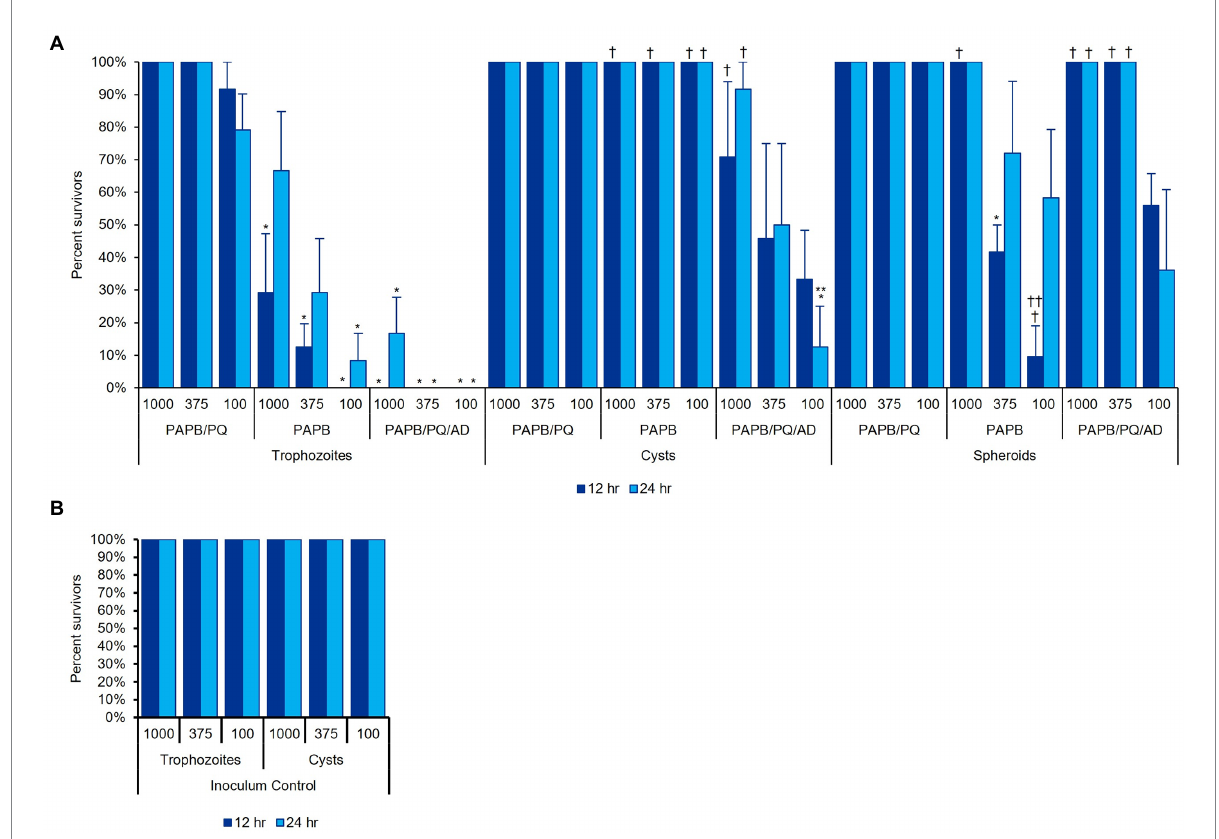
FIGURE 11 Acanthamoeba polyphaga (ATCC 30461) in three different cell concentrations (1,000, 375, or 100 cells per 100 μ l) was used to examine MPS disinfection efficacy against (A) trophozoites, cysts, and spheroids, after cells had adhered to the plate for 12 or 24 h. (B) An inoculum control was run concurrently with the same cultures used in (A) . Each bar represents a mean ± SE of 3 replicates, each replicate being composed of 8 wells from which percent survivorship was calculated. Statistical analysis via 2-way ANOVA: comparisons versus a MPS within the same cell condition and same time, * p < 0.05 vs. PAPB/PQ, ** p < 0.05 vs. PAPB; comparisons versus a cell condition within the same MPS and same time, † p < 0.05 vs. trophozoites, †† p < 0.05 vs.